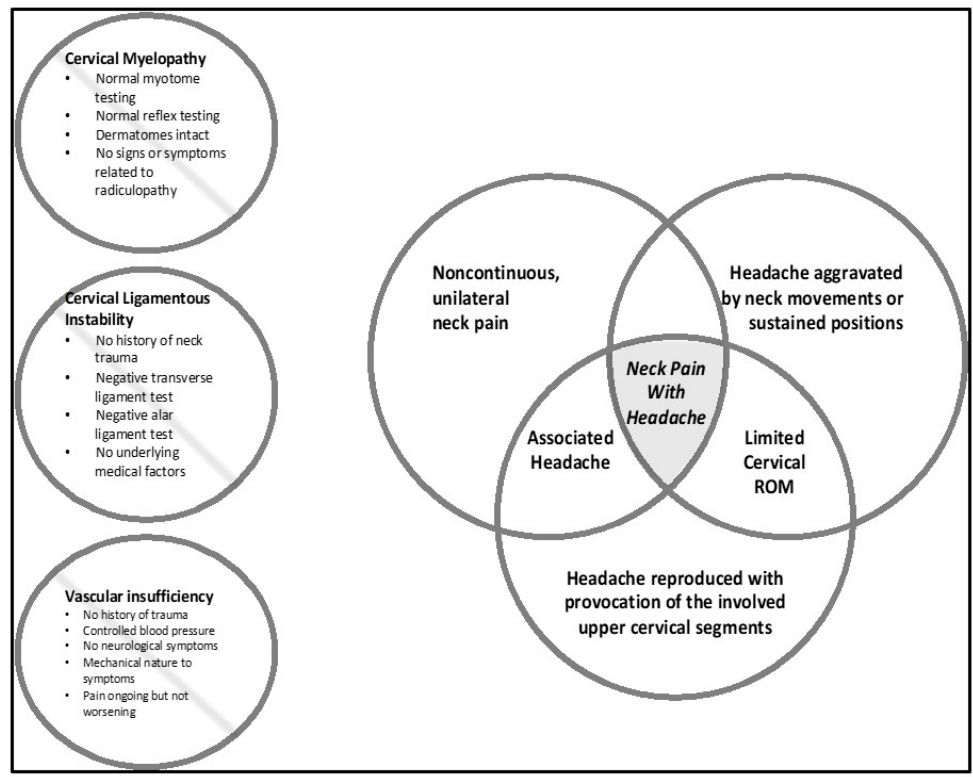
Figure 2. Differential diagnosis, according to American Physical Therapy Association’s revised clinical practice guidelines for neck pain [53]. Abbreviations: ROM, range of